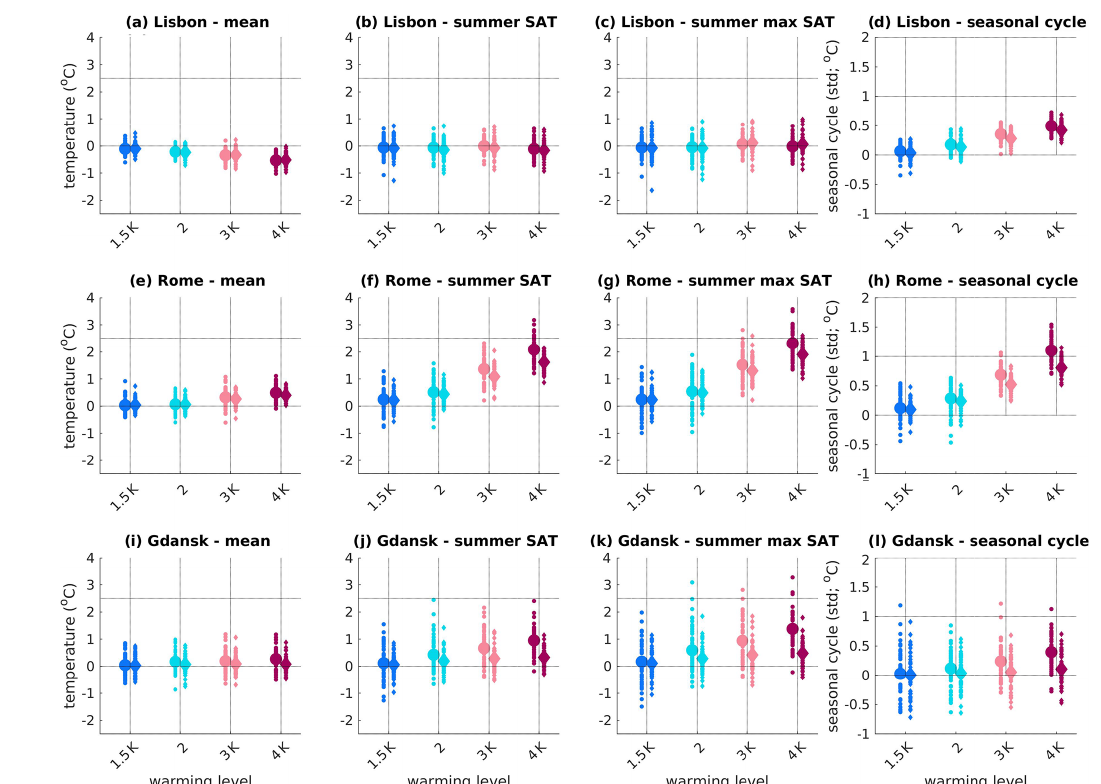
Figure 3. Annual-mean surface air temperature (SAT) (a, e, i) , summer SAT (b, f, j) , and summer max-SAT (c, g, k) and the seasonal cycle change (d, h, l) shown at each warming level relative to 1K of global warming. Shown for the GCM (circles) and the RCM (diamonds). Each ensemble member is shown in the small symbols with the ensemble mean in the large symbol. Shown for (a–d) Lisbon (38.7223 ◦ N, 9.1393 ◦ W), (e–h) Rome (41.9028 ◦ N,12.4964 ◦ E), and (i–l) Gda´nsk (54.3520 ◦ N, 18.6466 ◦ E). Each ensemble members change is computed relative to itself at 1K, with the global warming above 1K then subtracted for all variables except the seasonal cycle. The seasonal cycle is computed as the standard deviation over all 12 months after the 11-year period has been